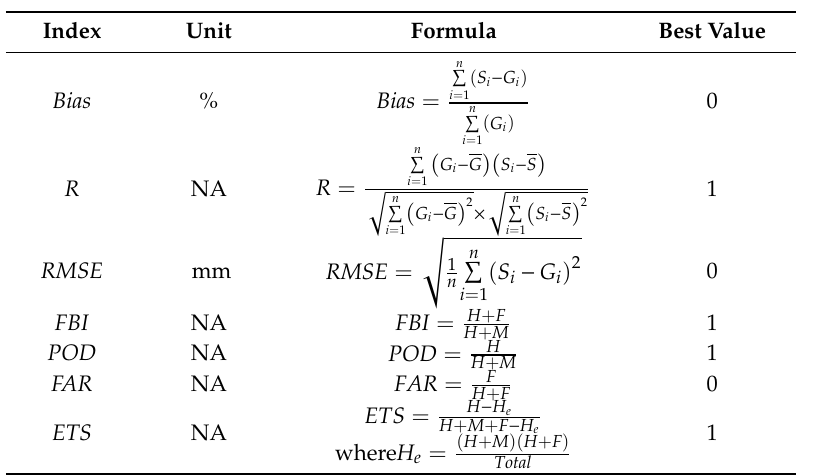
Table 2. Summary of statistical and skill metrics.